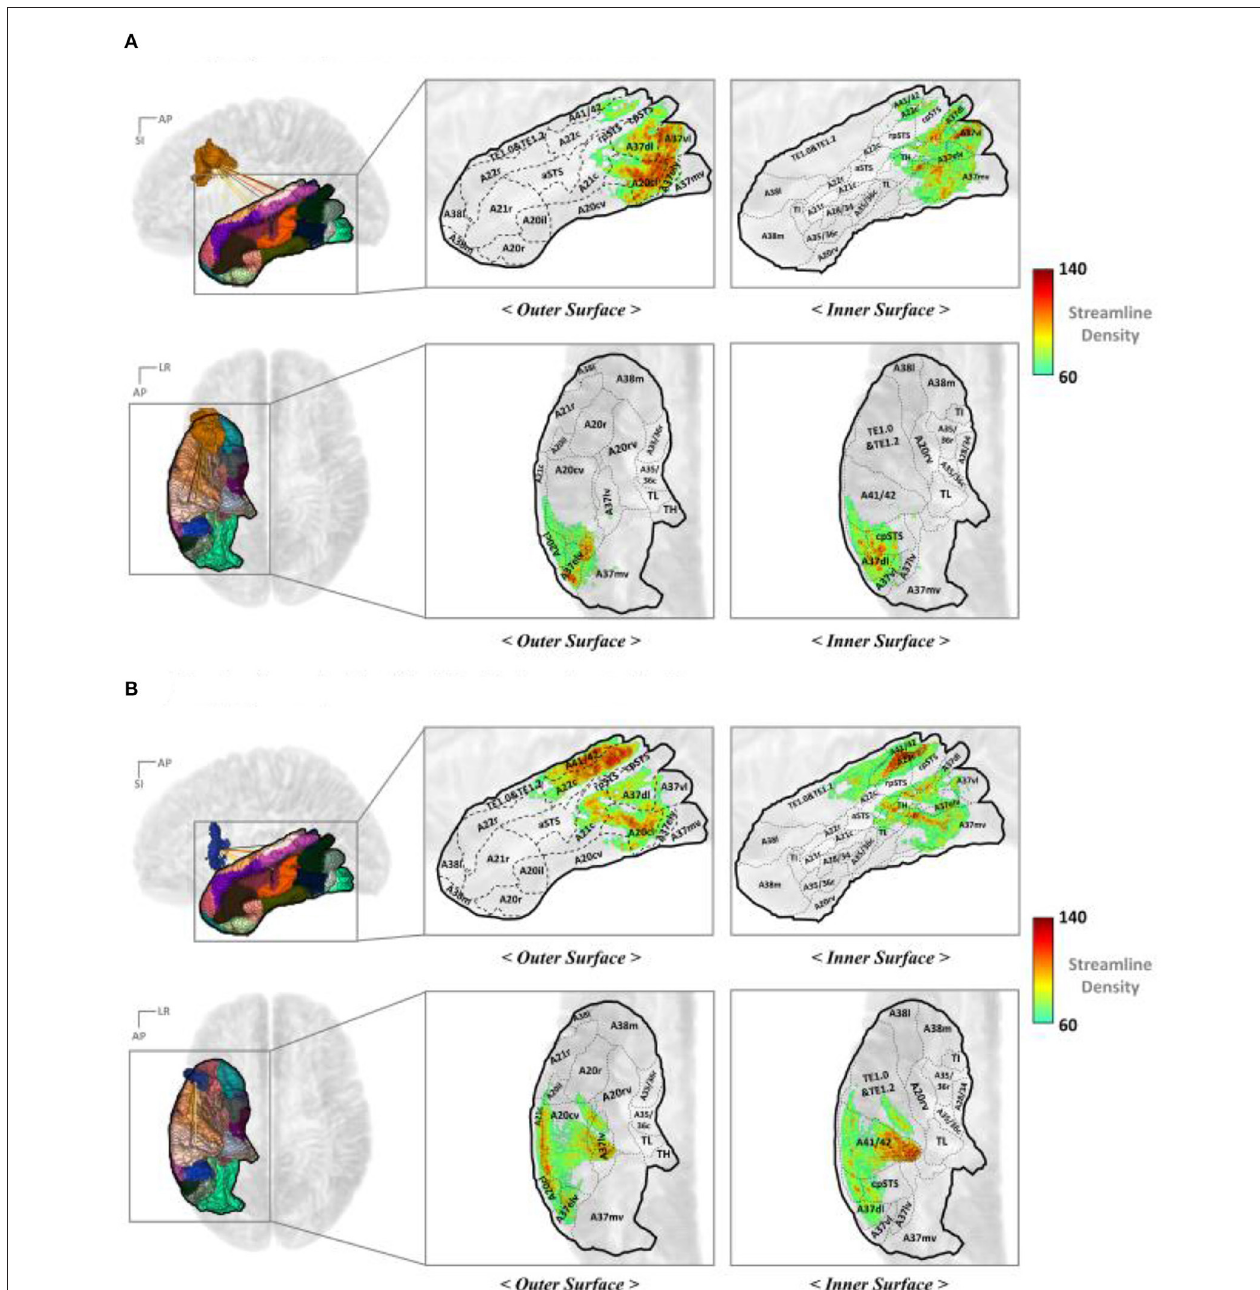
FIGURE 7 | Mapping the end points of the streamlines to the TC: (A) IFJ–TC streamlines and (B) A44v–TC streamlines. A8dl, dorsolateral area 8; A8m, medial area 8; A8vl, ventrolateral area 8; A9l, lateral area 9; A9m, medial area 9; A9/46d, dorsal area 9/46; A10l, lateral area 10; A10m, medial area 10; A11l, lateral area 11; A11m, medial area 11; A12/47l, lateral area 12/47; A12/47o, opercular area 12/47; A14m, medial area 14; A13, area 13; A21c, caudal area 21; A21r, rostral area 21; A22c, caudal area 22; A22r, rostral area 22; A37dl, dorsolateral area 37; A38l, lateral area 38; A38m, medial area 38; A41/42, area 41/42; A44d, dorsal area 44; A44op, opercular area 44; A44v, ventral area 44; A45c, caudal area 45; A45r, rostral area 45; A46, area 46; aSTS, anterior superior temporal sulcus; IFJ, inferior frontal junction; IFS, inferior frontal sulcus; TE, TE 1.0 and TE 1.2.